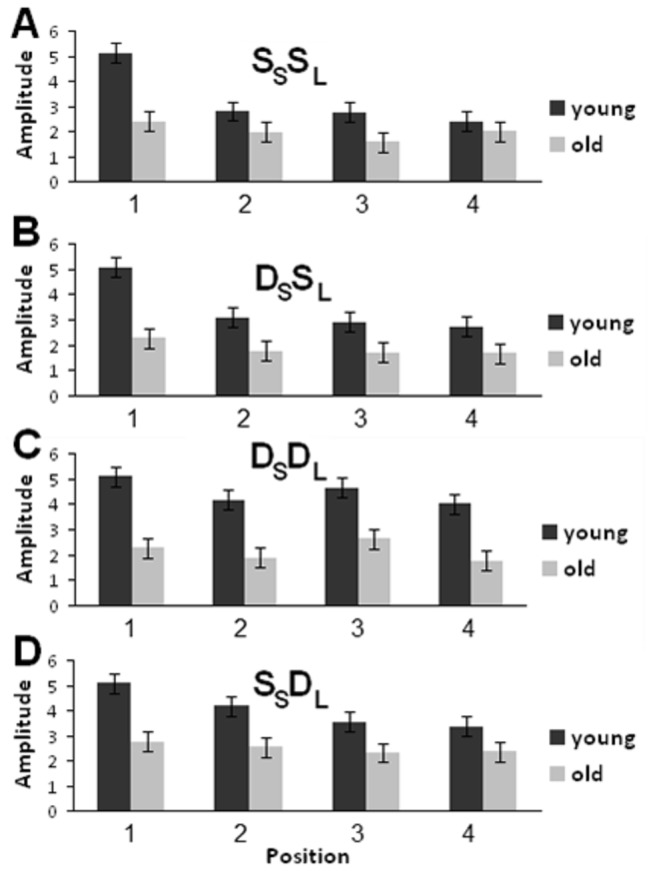
Plot of P2 peak amplitudes across the four positions regardless of noise.(A) S SSL trials. (B) DSSL trials. (C) DSDL trials. (D) SSDL trials. Error bars indicate standard error of the mean.